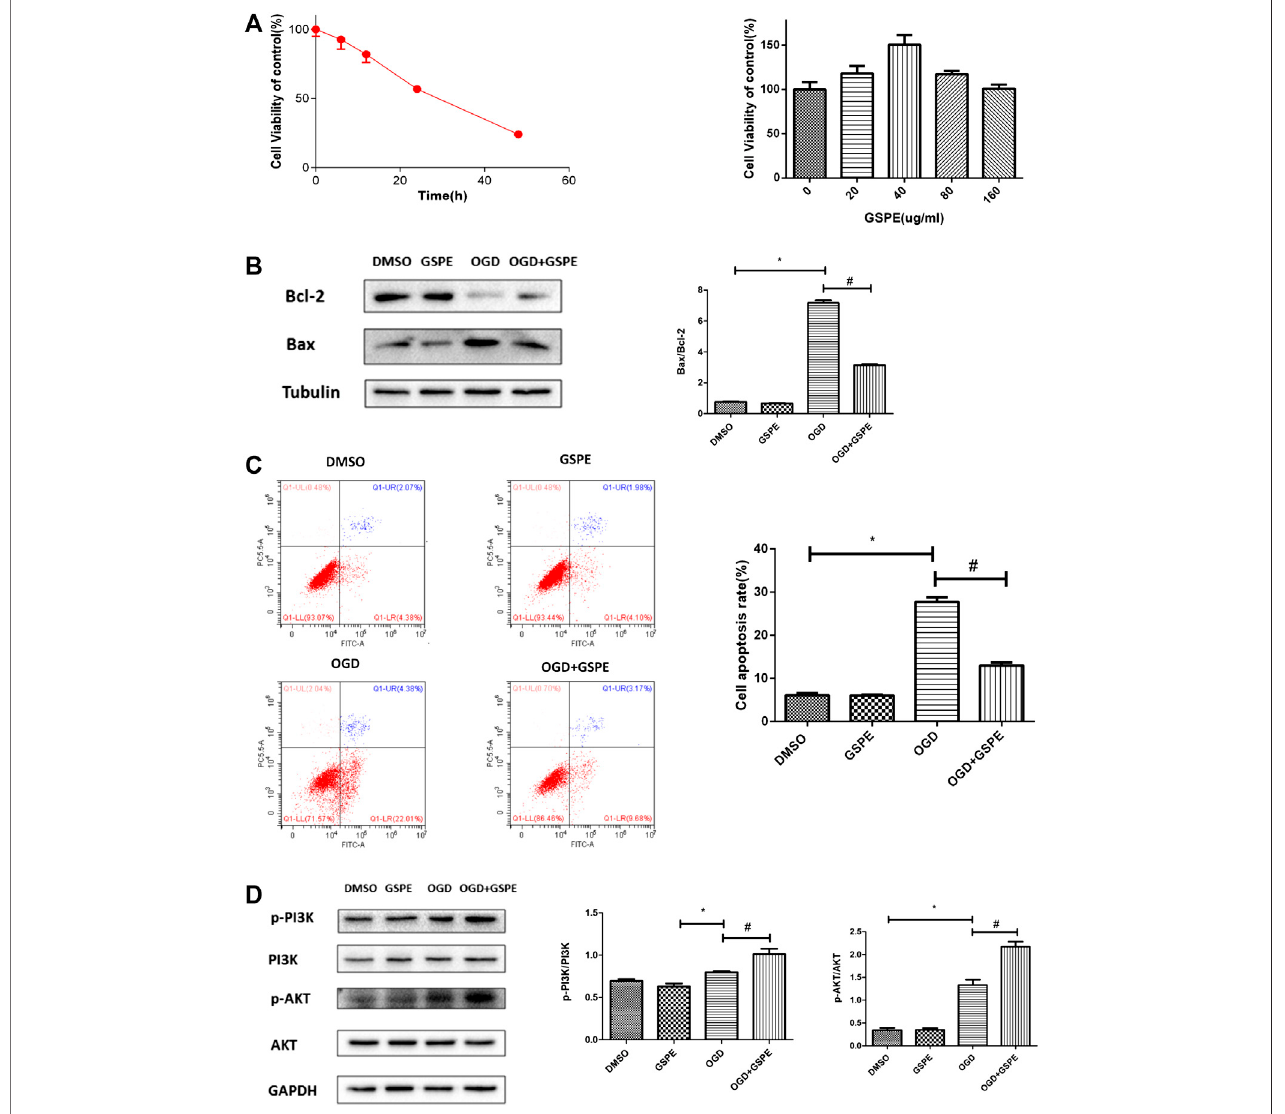
FIGURE 6 | GSPE reduced apoptosis in H9C2 cells under oxygen-glucose deprivation through PI3K/AKT pathway. (A) H9C2 cells were culture under hypoxia condition for different time, CCK8 assay was used to assess the cell viability. The appropriate GSPE concentration eas evaluated by CCK8 assay after the cells were culturedunderglucoseoxygendeptrivationfor24hours.*Signi fi cantdifferencecomparedwiththeDMSOgroup,P < 0.05. (B) EffectsofGSPEontheexpressionofBax and Bcl-2 evaluated by Western blot analysis. (C) H9C2 cells in different treatment were stained by Annexin V-FITC/PI staining and then distinguished by fl ow cytometer.Thecellapoptosis ratewasquanti fi ed. (D) EffectsofGSPE treatment ontheH9C2 cellsofp-PI#K, PI#K, p-AKTand AKTevaluatedbyWesternblotanalysis. Data analyzed are mean ± SD. *Signi fi cant difference compared with the DMSO group, p < 0.05; #signi fi cant difference compared with the OGD group, p < 0.05. n (cid:2) 3 per